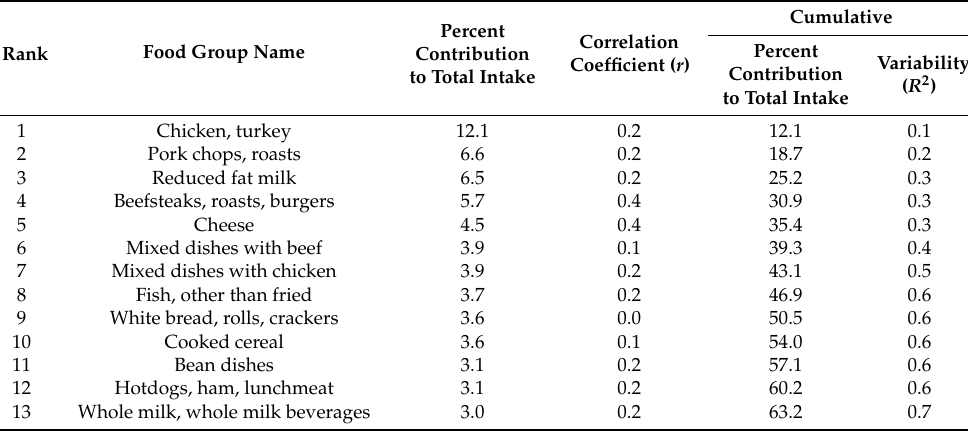
Table 3. Foods contributing to protein (g) intake, Puerto Rican